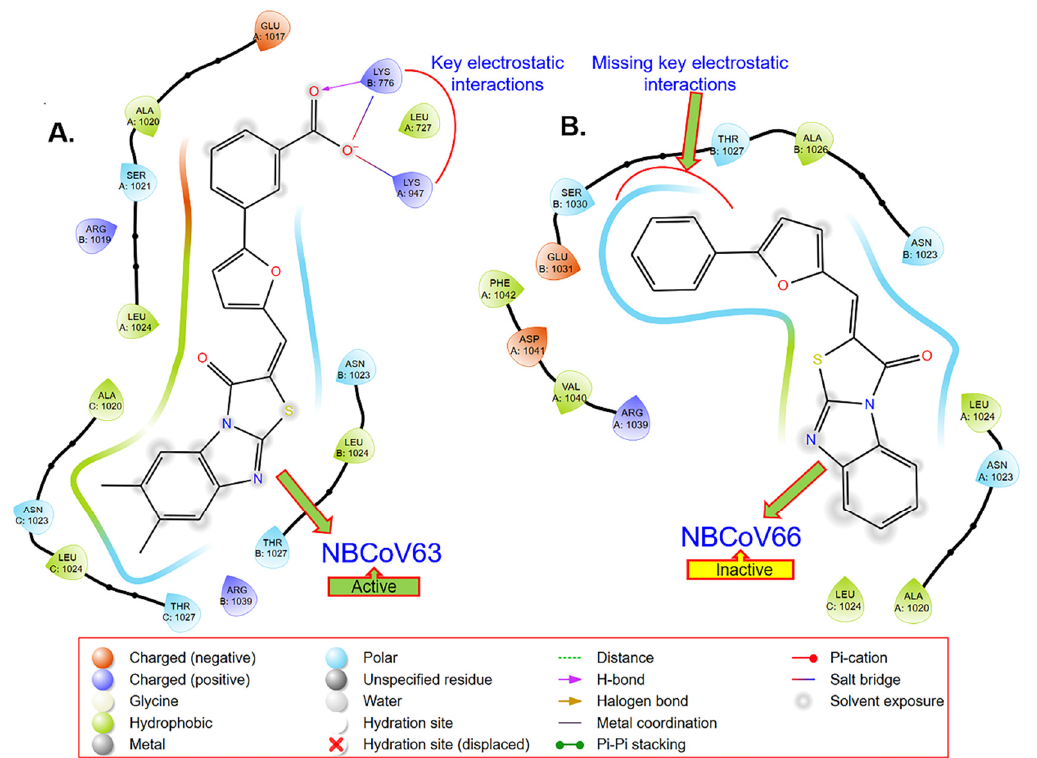
Figure 2. GLIDE-based docking of an active and an inactive NBCoV demonstrates that ( A ) the COOH group of the active compound (NBCoV63) has the key salt-bridge interactions; ( B ) these key interactions are